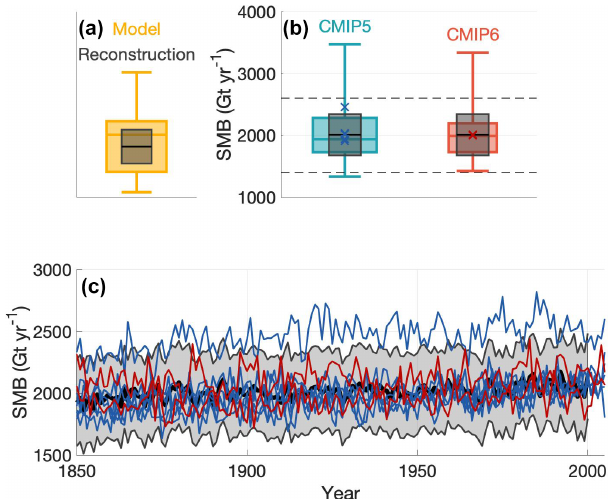
Figure 4. Box plots of the linear trends in spatially integrated AIS SMB in CMIP5 (blue) and CMIP6 (red) for the periods (a) from 1850 to 2000, (b) from 1900 to 2000, and (c) from 1950 to 2000. In all three panels, the grey boxes denote the reconstructed uncer- tainty around the reconstructed trend (black line). The eight best scoring models are represented by dark blue x’s if they are among the CMIP5 suite of models or red x’s if they are among the CMIP6